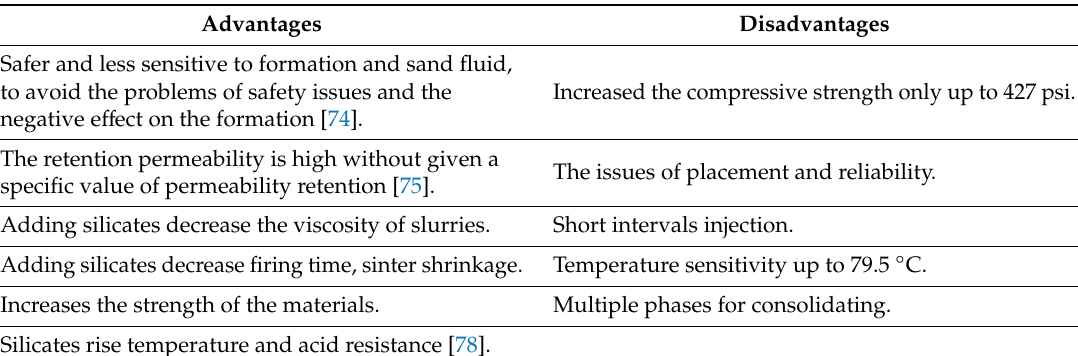
Table 10. Advantages and disadvantages of silicate